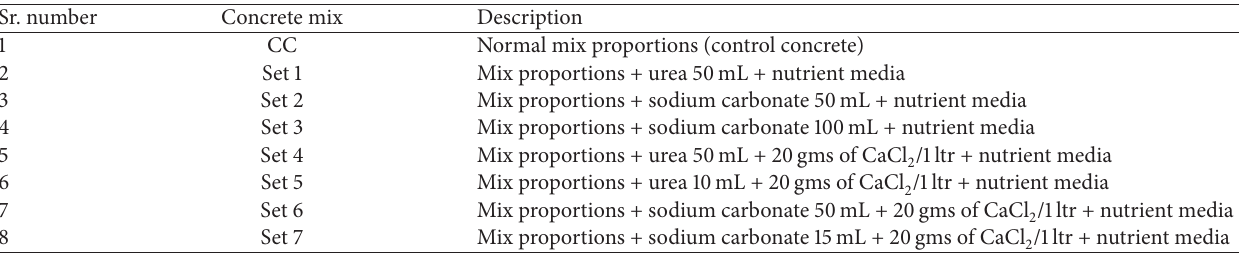
Table 1: Composition of chemicals used in bioconcrete.